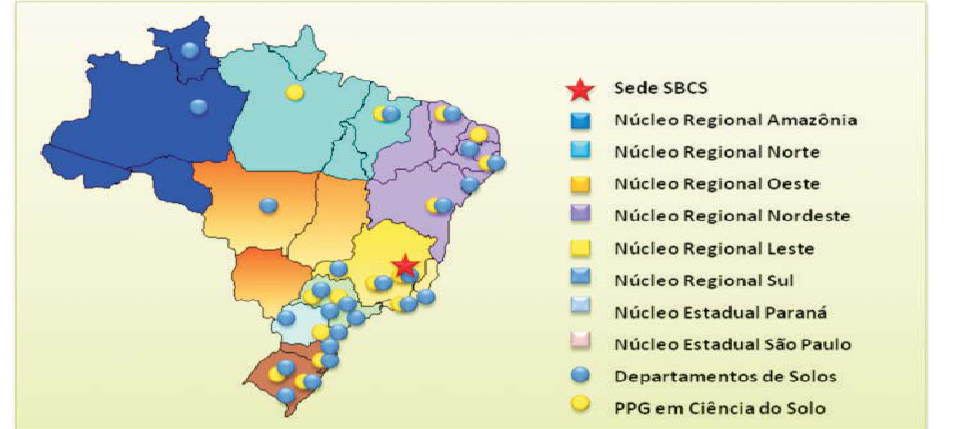
Figure 1. SBCS headquarter and regional nuclei, Department of Soils and Graduate Programs in Soil Science in Brazil.